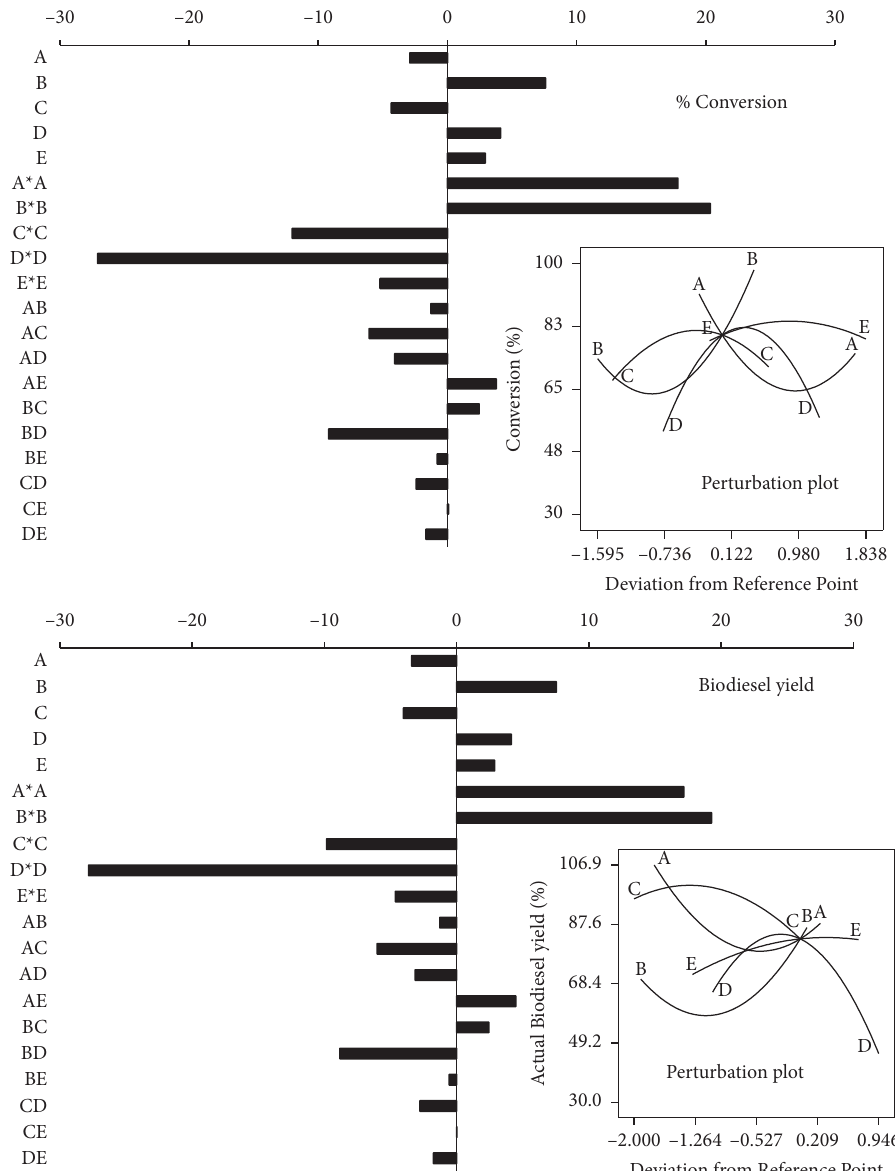
Figure 7: Pareto charts and perturbation plots representing the main and interactive efects of the studied parameters on the trans- esterifcation